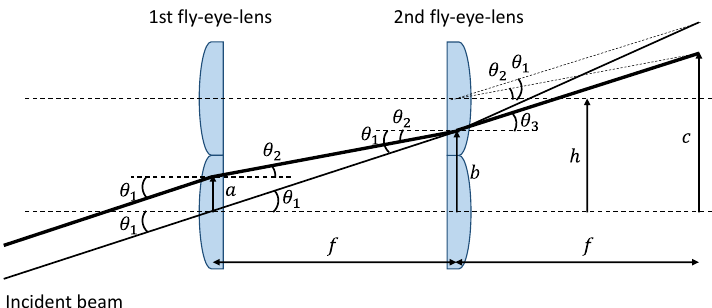
Figure 8. Relationship of beam angles for fly-eye lens.